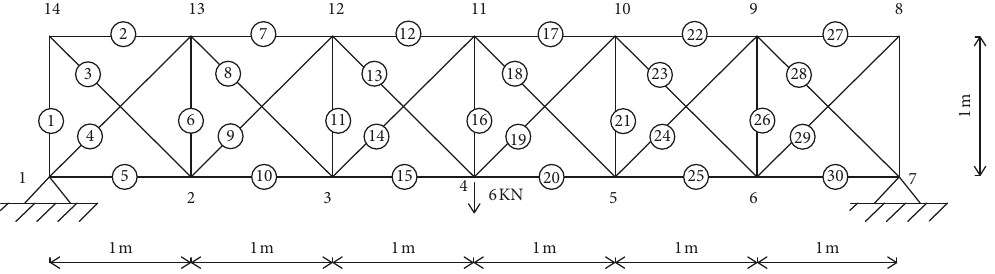
Figure 8: A six bay plane truss structure.